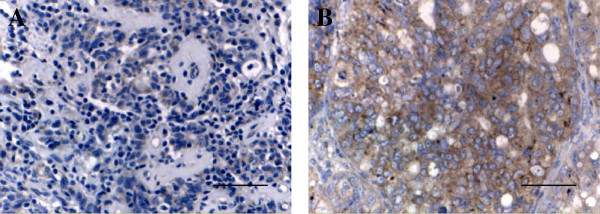
The expression of MMP-2 in clinical stage I and clinical stage III ovarian carcinoma. A, MMP-2 was weakly expressed in Clinical stage I ovarian carcinoma; B, MMP-2 was strongly expressed in clinical stage III ovarian carcinoma. [bar line = 50 μm].